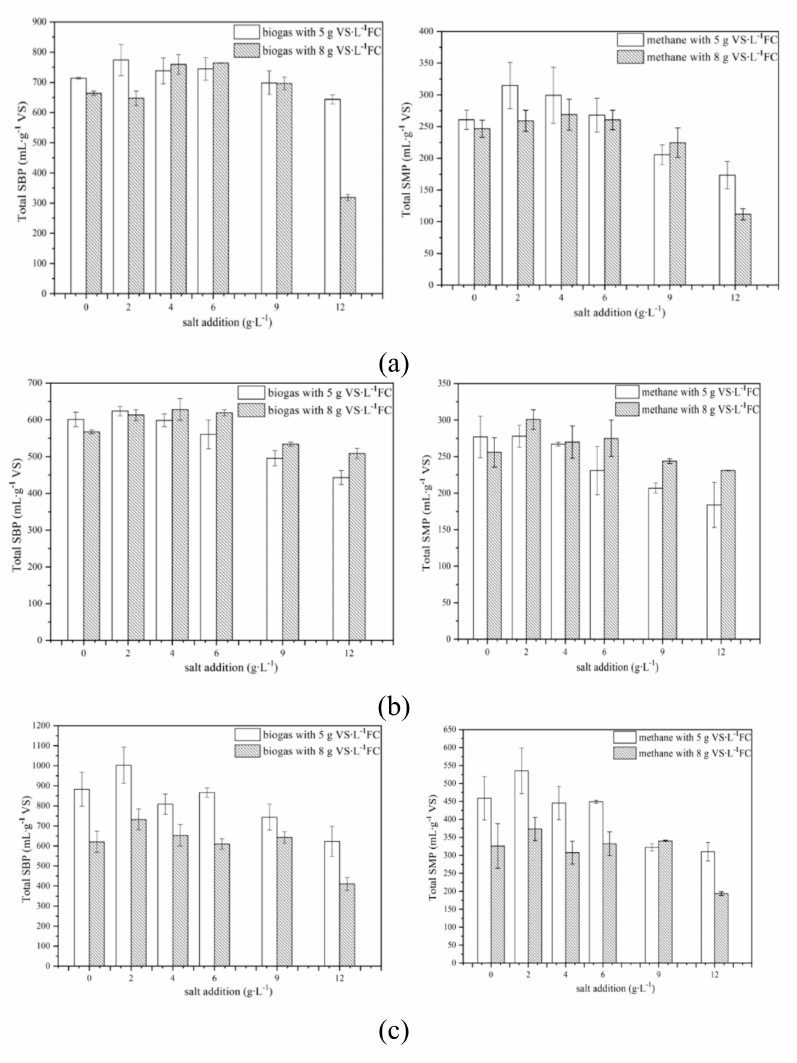
Figure 1. Specific biogas production (SBP) and specific methane production (SMP) of ( a ) HCFW, ( b ) HPFW, ( c ) HFFW with di ff erent salt additions. Table 2. Total SBP, total SMP and vs. removal of skimmed soybeans with di ff erent levels of salt addition and fermentation